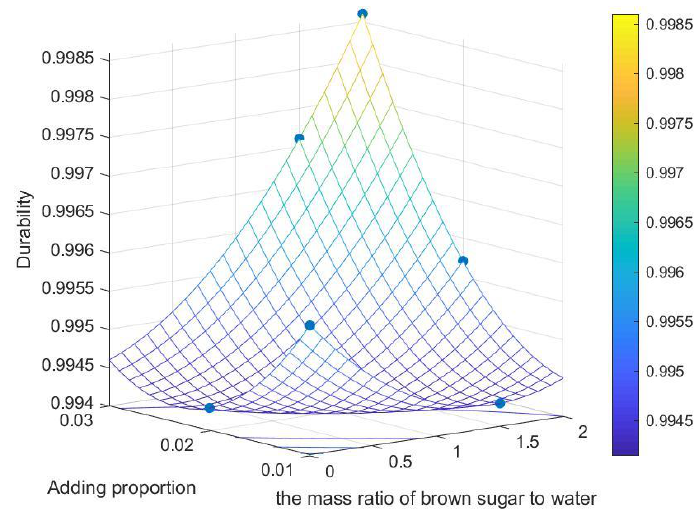
Figure 10. Relation diagram of durability–add proportion and the mass ratio of brown sugar to water.